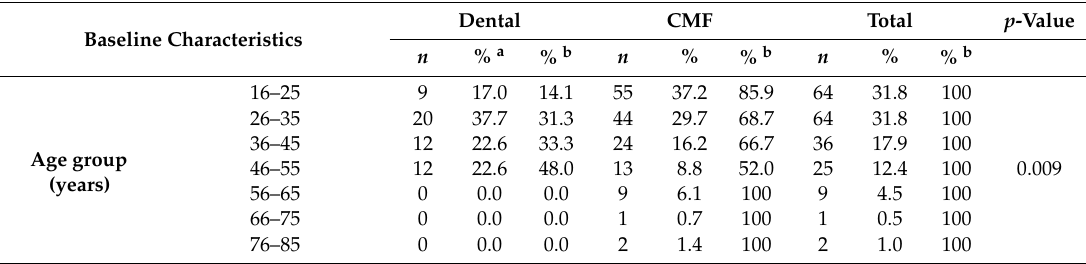
Table 1. Distribution of age groups, gender, and nationality between dental patients (Dental) and craniomaxillofacial (CMF) emergencies. Legend: a Total percentage within the columns; b Total percentage within the rows; CMF: